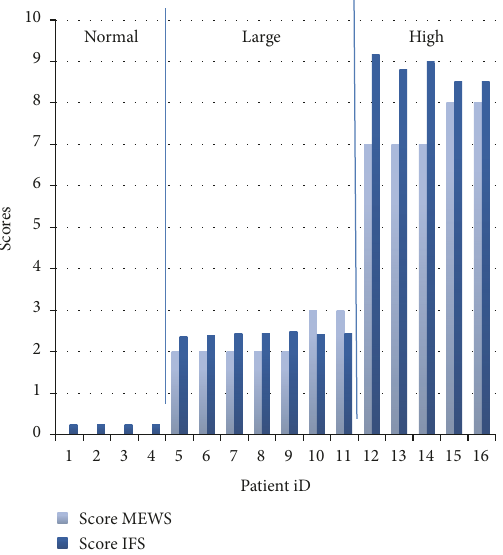
Figure 7: Column chart for MEWS score and the